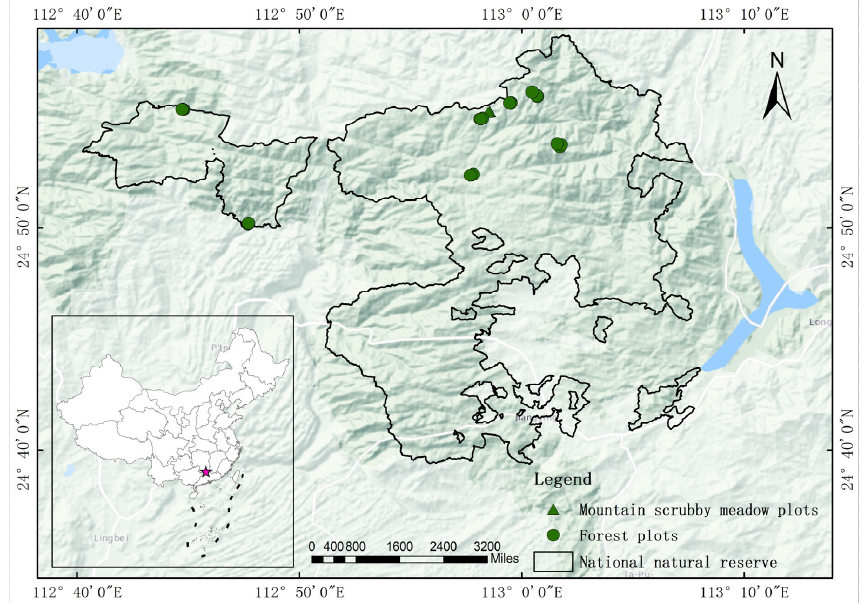
Figure 1. Geographical locations of the study area.